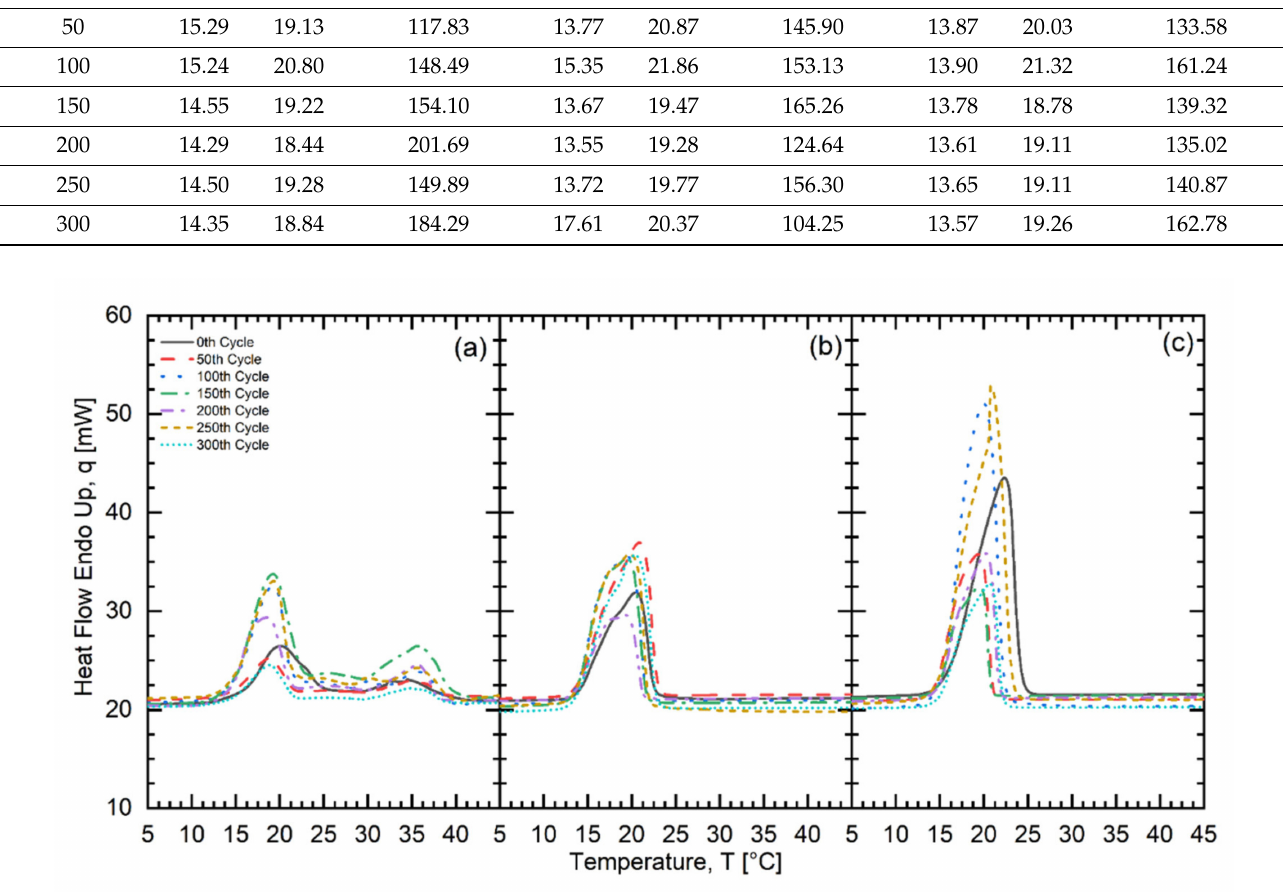
Figure 3. Cycle testing ( a ) CLP303535 ( b ) CLP701515 ( c )